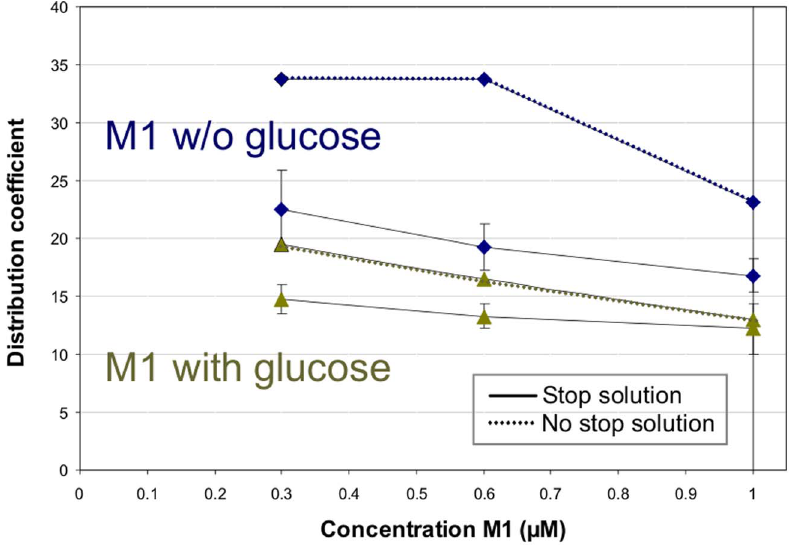
Figure 2. Influence of the stop solution on the uptake of M1 into human erythrocytes. In an initial experiment the distribution of different concentrations of the metabolite M1 was analyzed in the absence and presence of glucose (100 mM) with and without addition of a stop solution containing phloretin (200 m M) and cytochalasin B (20 m M). Data points of the experiments with stop solution (solid lines) represent the mean and mean deviation of the mean of three replicates, the data points without stop solution (dashed lines) were single experiments.